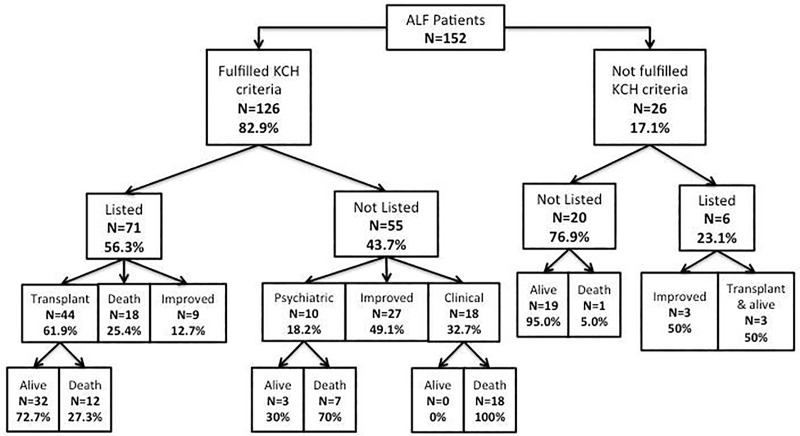
Flow chart of patients’ outcome in the study.Patients were first divided according to whether they fulfilled or not KCH criteria and therefore were listed or not for liver transplantation. Reasons for liver transplant ineligibility and the outcome of the different categories were reported. ALF: Acute Liver Failure; KCH: Kings College criteria.